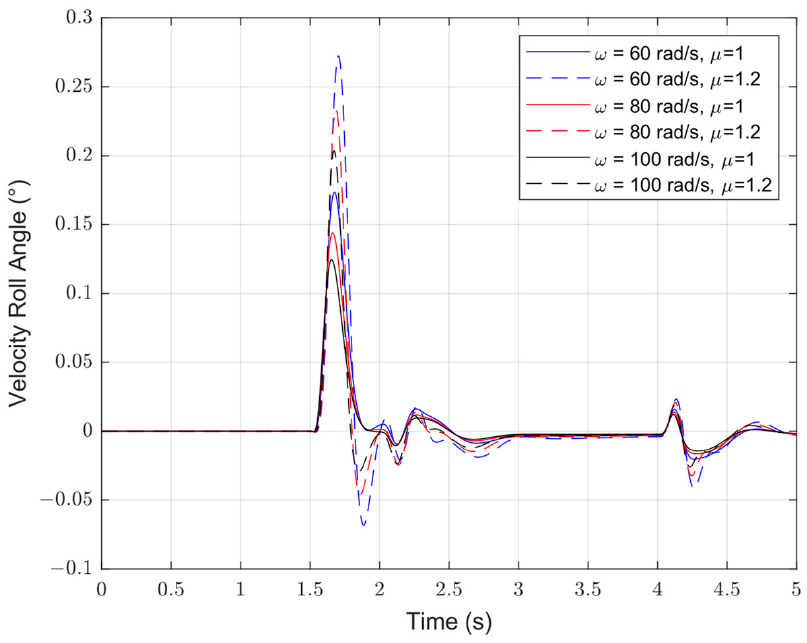
Figure 12. Response of Speed Roll Angle with External Disturbance.